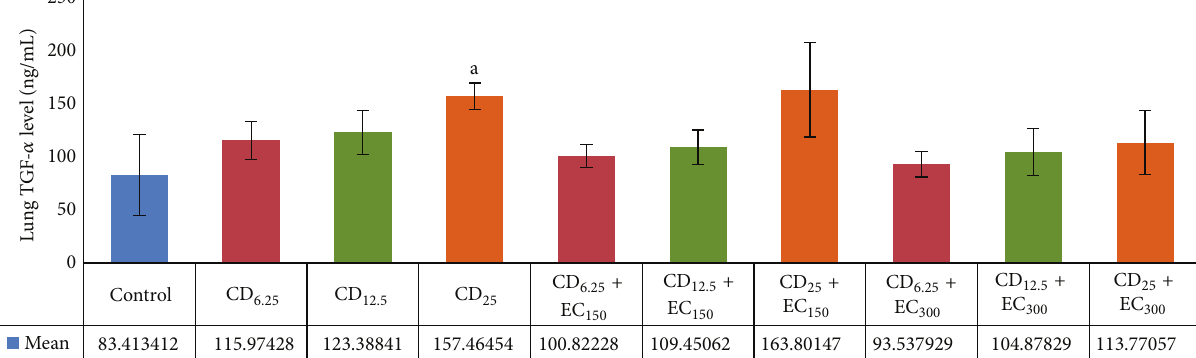
Figure 5: The levels of lung TGF- 𝛼 . The lung TGF- 𝛼 level was increased in coal dust-exposed group at dose of 25 mg/m 3 than that in nonexposure group but decreased by supplementation of E. cottonii at dose of 300 mg/kg BW. a 𝑃 < 0.05 in comparison with non-exposure group, b 𝑃 < 0.05 in comparison with its coal dust-exposed non-supplemented group. Non-exposure group (control); group exposed to coal dust at dose of 6.25 mg/m 3 (CD 6.25 ), 12.5mg/m 3 (CD 12.5 ), or 25 mg/m 3 (CD 25 ); group supplemented with the ethanolic extract of E. cottonii at dose of 150 (EC 150 ) or 300mg/kg BW (EC 300 ).